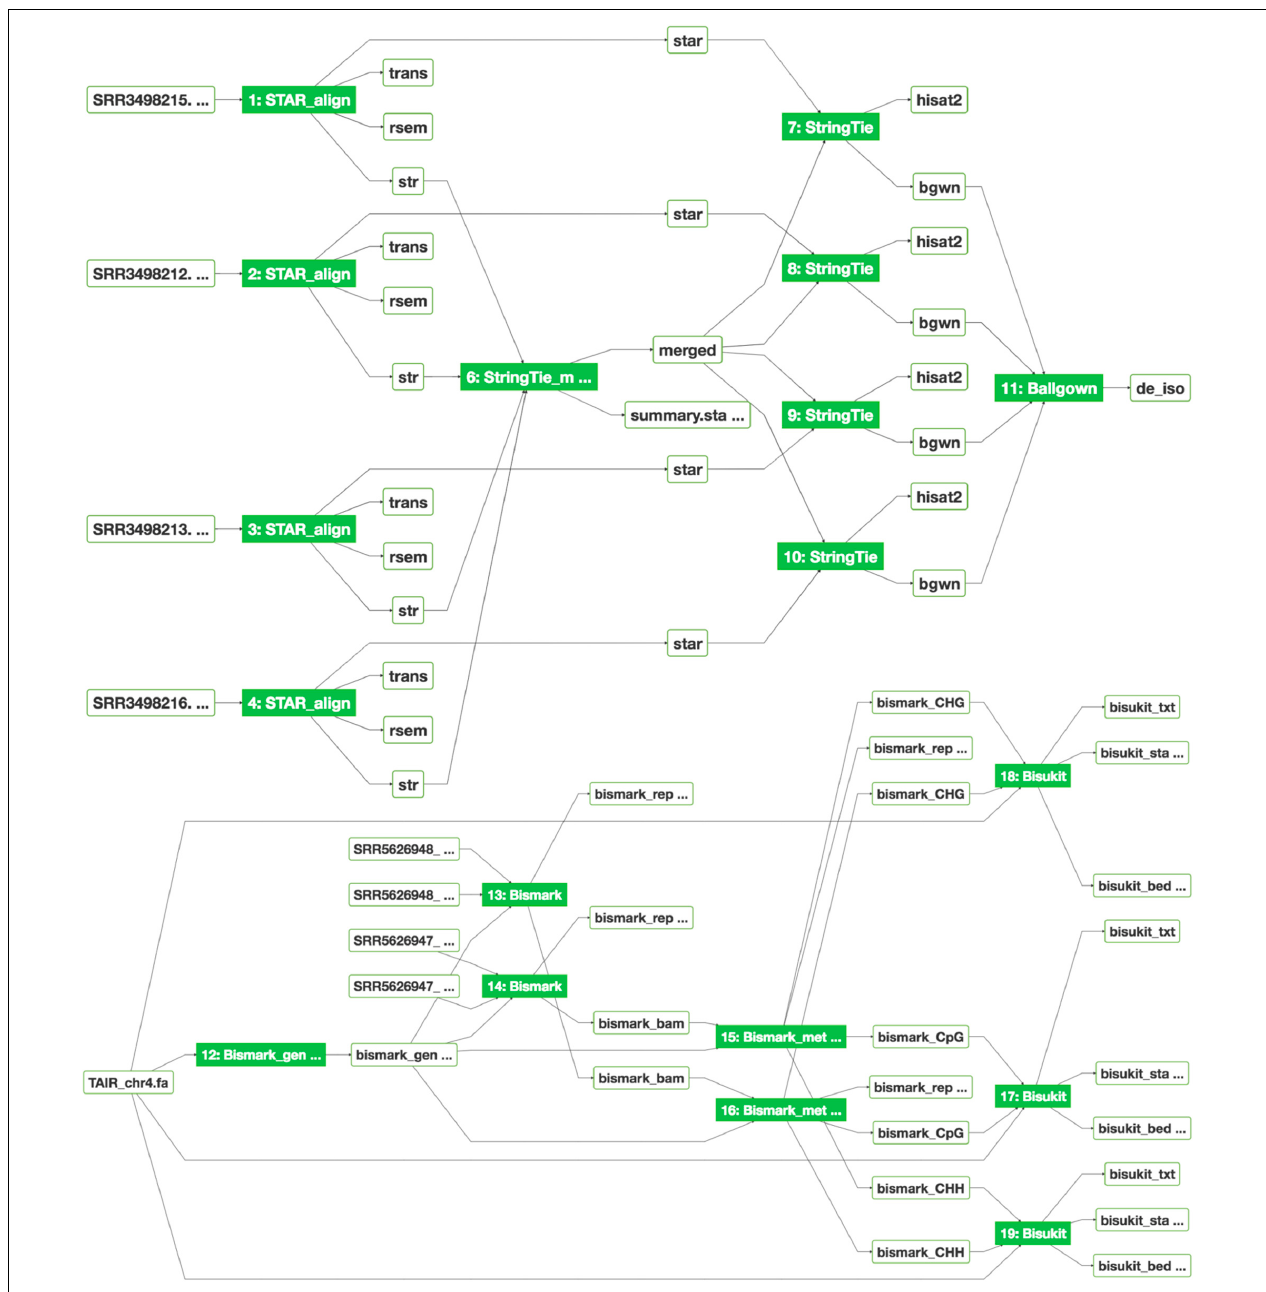
FIGURE 3 | Graphical workflow diagrams for differential expression analysis (top) and MethylC-seq analysis (bottom). The interactive graph demonstrates the relationships among input–output files, displays provenance of the software tools, and provides real-time job status updates of new analyses via the color of the app node (green: completed; blue: running; yellow: pending; red: failed). Blue, yellow, and red colors are not